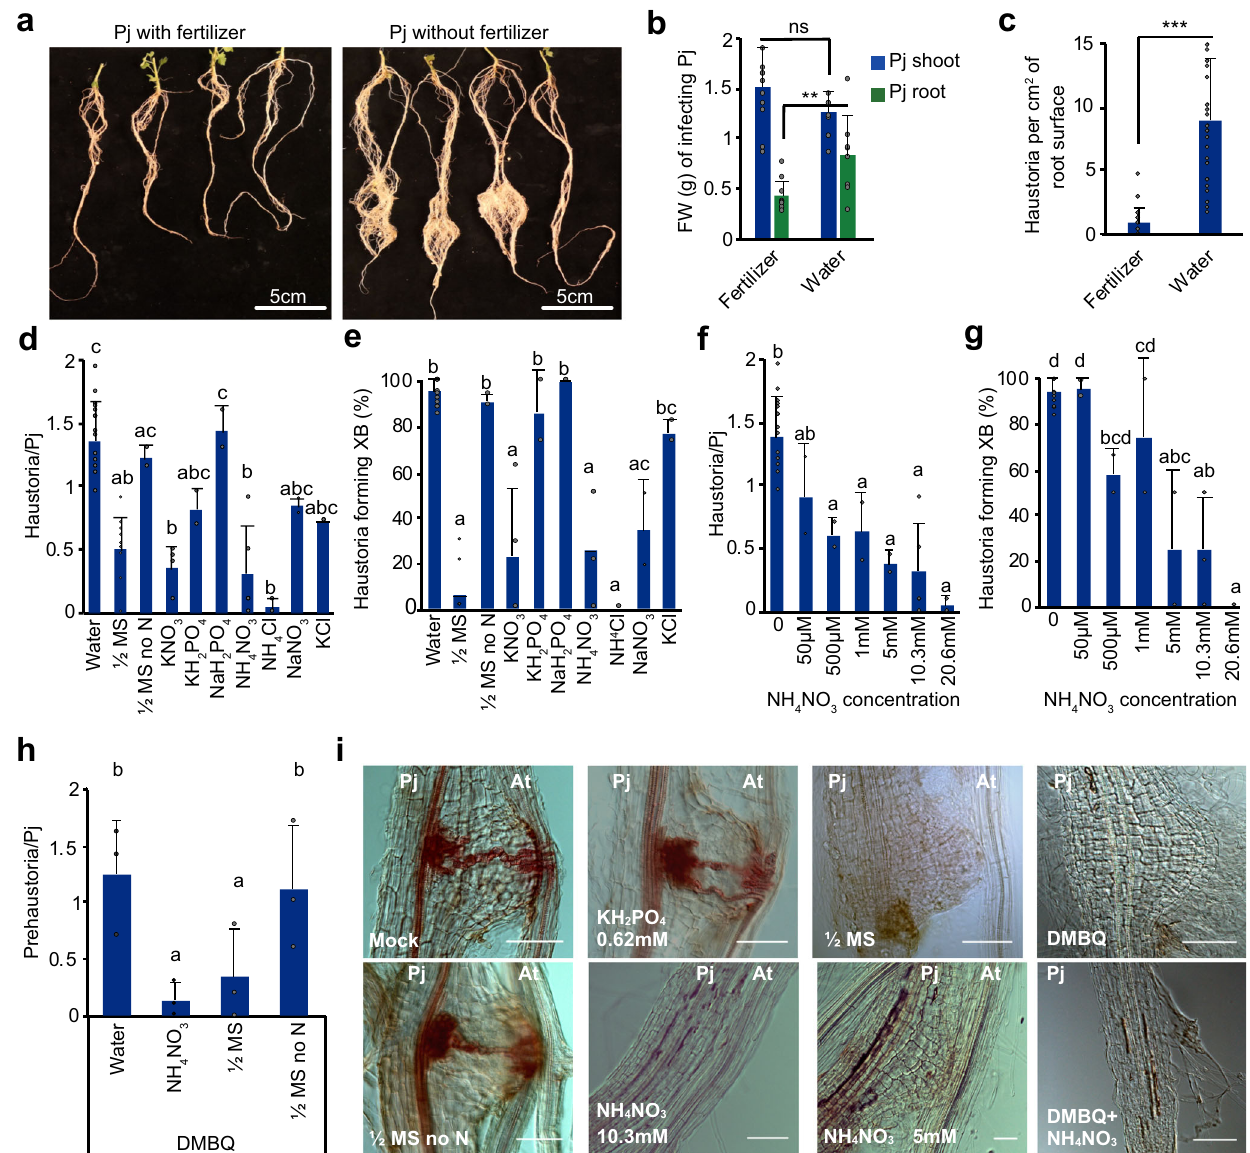
Fig. 1 Nitrogen inhibits P. japonicum haustoria formation. a , b Representative images and shoot and root fresh weight (FW) of P. japonicum during Arabidopsis infection with and without fertilizer (mean ± SD, n fertilizer = 11 plants, n water = 8 plants). c Haustoria numbers per cm 2 P. japonicum root during Arabidopsis infection with and without fertilizer (mean ± SD, n fertilizer = 24 images analyzed, n water = 37 images analyzed). d – g Haustoria numbers per P. japonicum seedling and xylem bridge formation percentage in in vitro Arabidopsis (Col-0) infections on ½MS (9 replicates), ½MS no N (2 replicates), 20.6 mM KNO 3 (4 replicates), 10.3 mM NH 4 NO 3 (5 replicates), 0.62 mM KH 2 PO 4 (2 replicates), 1.9 mM NaH 2 PO 4 (2 replicates), 10.3